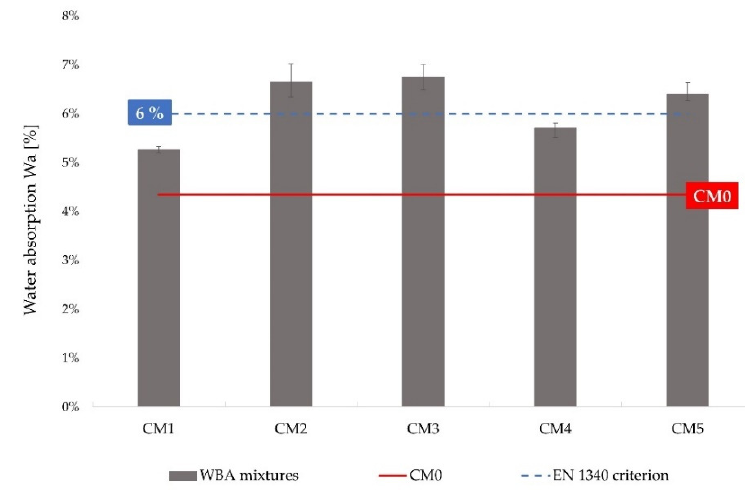
Figure 9. Total water absorption of concrete specimen with WBA in relation to control mix.